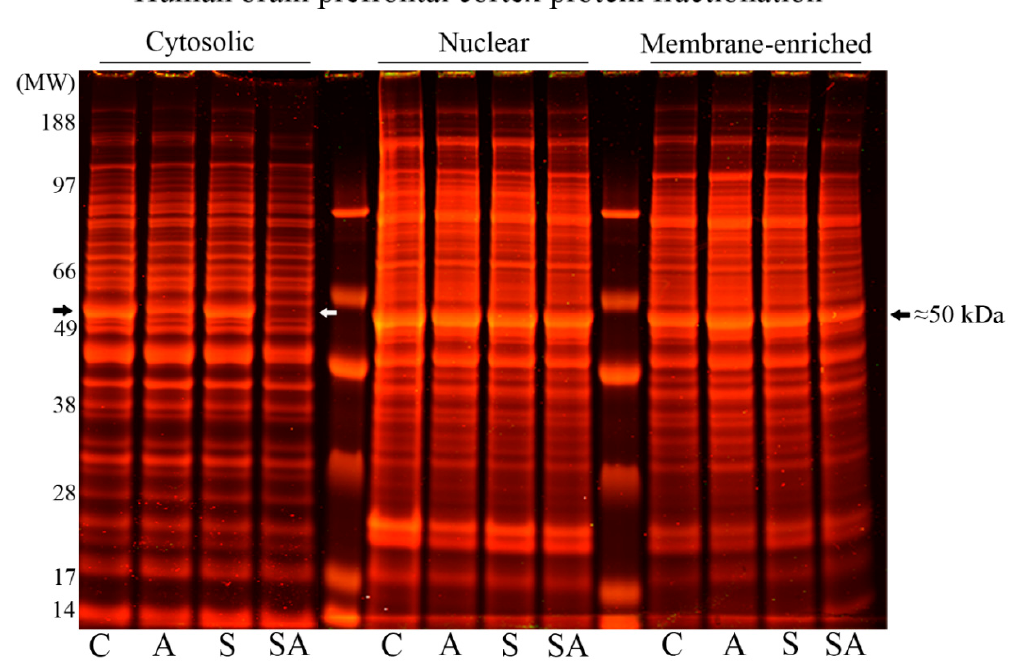
Figure 1. Resolution of human PFC proteins from cytosolic, nuclear, and membrane-enriched fractions from control (C), alcoholic (A), suicide (S), and suicide alcoholic (SA) patients. Prefrontal cortex proteins were resolved by one dimensional polyacrylamide gel electrophoresis and then stained with colloidal Coomassie. Reduced protein staining at ≈ 50 kDa (marked with arrowheads) was solely in the cytosolic protein fractions of alcoholic and suicide alcoholic patients.